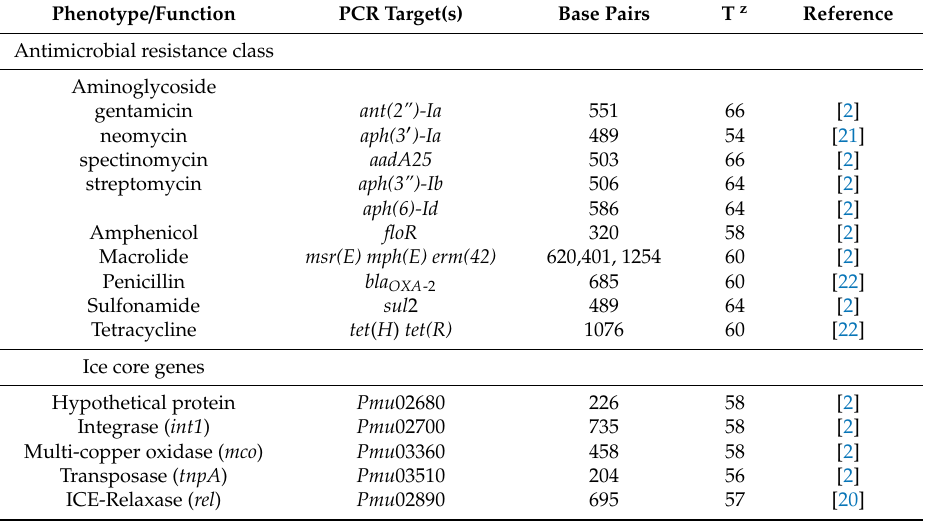
Table 1. Antimicrobial resistance and ICEP mu1 core gene targets for PCR-based